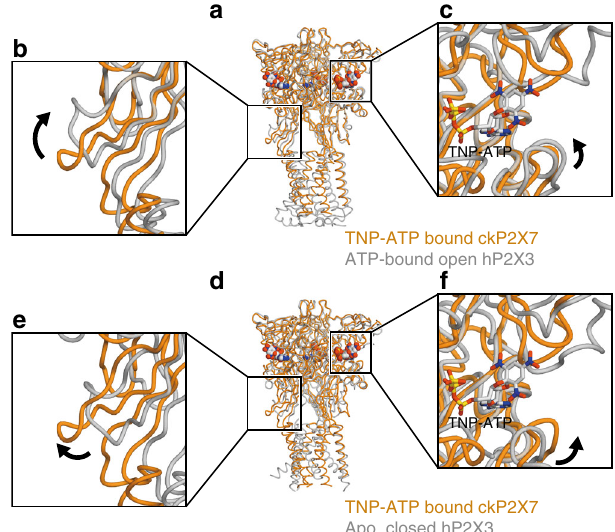
Fig. 4 Comparison of the overall structures of the apo closed, and TNP- ATP-bound and ATP-bound, open states for ckP2X7 and hP2X3. a – c Subunit comparisons of the TNP-ATP-bound ckP2X7 ( orange ) and ATP-bound, open hP2X3 ( gray , PDB ID: 5SVK) structures. Close-up views of the lower body domain ( b ) and the TNP-ATP binding site in the TNP-ATP-bound ckP2X7 structure ( c ) are shown in each box. The black arrows denote the movement from the TNP-ATP-bound state to the ATP-bound, open state. d – f Subunit comparisons of the TNP-ATP-bound ckP2X7 ( orange ) and apo, closed hP2X3 ( gray , PDB ID: 5SVJ) structures. Close-up views of the lower body domain ( e ) and the TNP-ATP binding site in the TNP-ATP-bound ckP2X7 structure ( f ) are shown in each box. The black arrows denote the movement from the apo, closed state to the TNP-ATP-bound